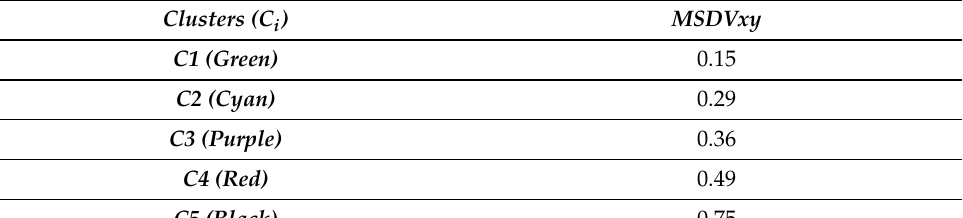
Table 6. The obtained MSDVxy average value when all samples of each cluster ( C i ) of Solution 1 are considered.